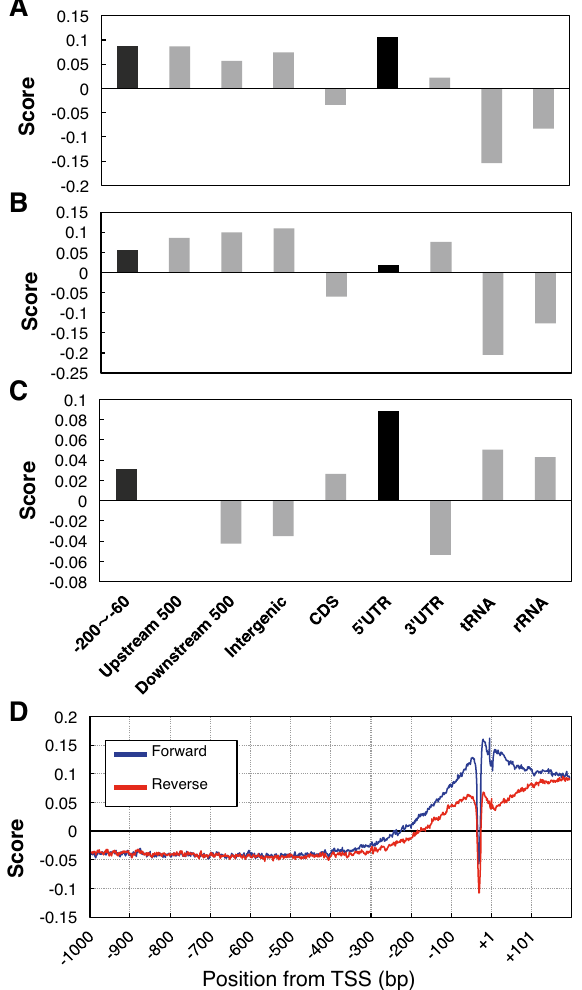
Figure 6. Specificity of rice PRI. ( A ) to ( C ). Scores of genic domains and transcribed region of a few gene categories are shown. The number of sequences used are: − 200 to − 60, Upstream 500, and Downstream 500 = 11.325; Intergenic = 11,666; CDS = 14,679; 5’ UTR = 8,443; tRNA = 156; rRNA = 3. Sequences of − 200 to − 60, Upstream 500, Downstream 500, tRNA, and rRNA were obtained from RAPDB, and the others from MSU7. ( A ) IGI200_60, ( B ) IGI750_450, ( C ) PRI200_60-750_450. Regions giving positive scores in all three IGI/ PRI are highlighted in black. ( D ) PRI along the promoter region. Average of Genic Top promoters is